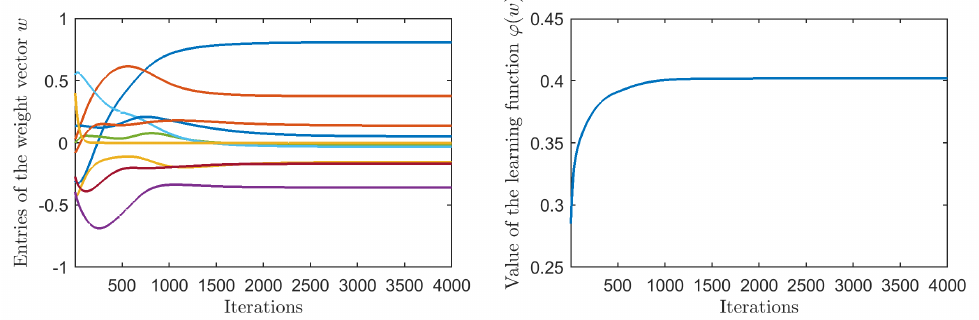
Figure 6. ( Left ) Time-evolution of the 10 components of the weight vector w during learning of the exponentiated-gradient ICA neural network. ( Right ) Time evolution of the learning criterion ϕ during learning of the exponentiated-gradient ICA neural